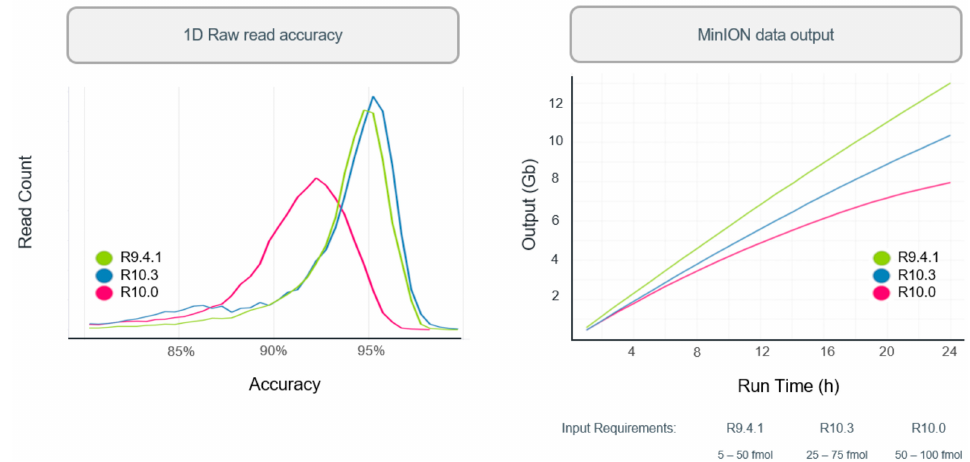
Figure 5. The comparison of performance using different types of nanopore. Oxford Nanopore Technologies Inc., Oxford, UK, 2020 [59] .